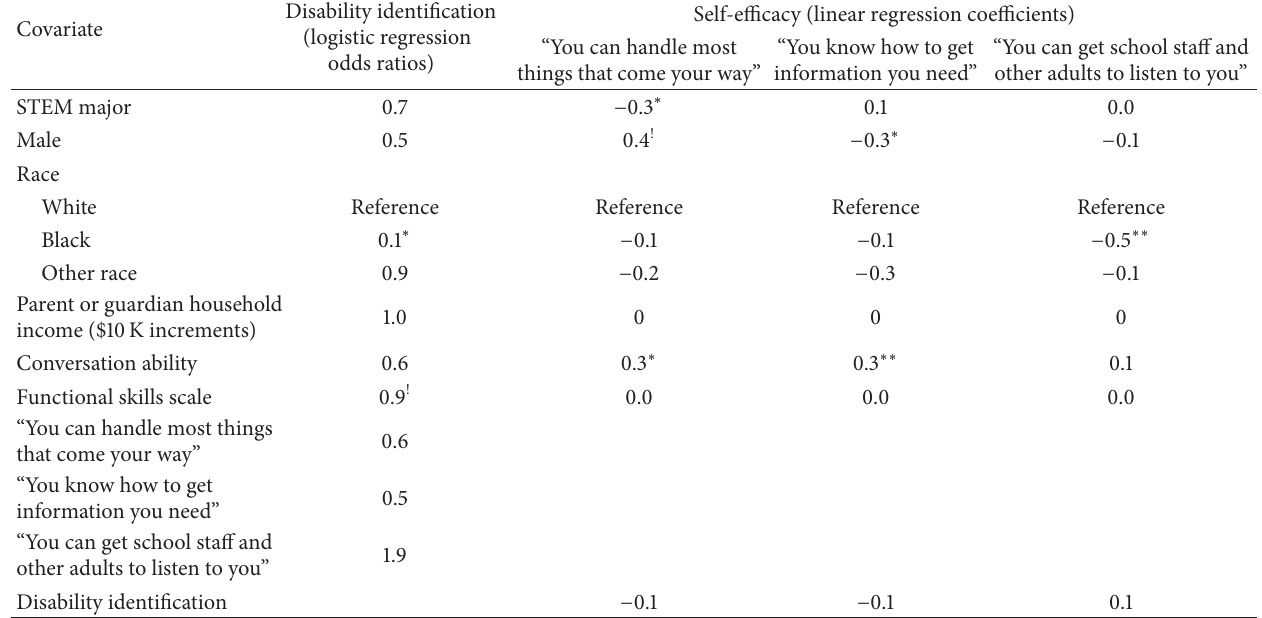
Table 2: Regression model